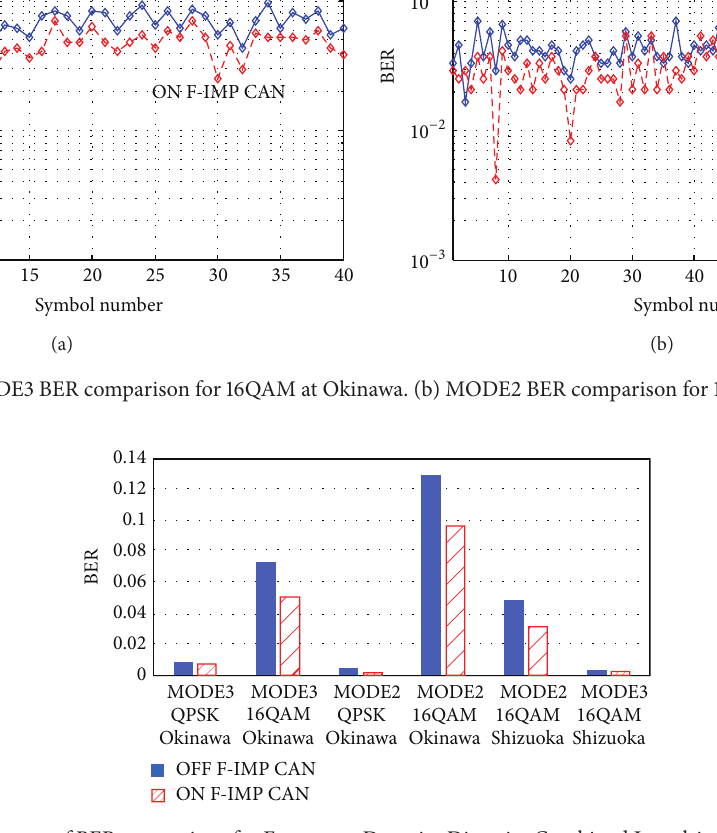
Figure 10: Summary of BER comparison for Frequency Domain. Diversity Combined Impulsive Noise Canceller.